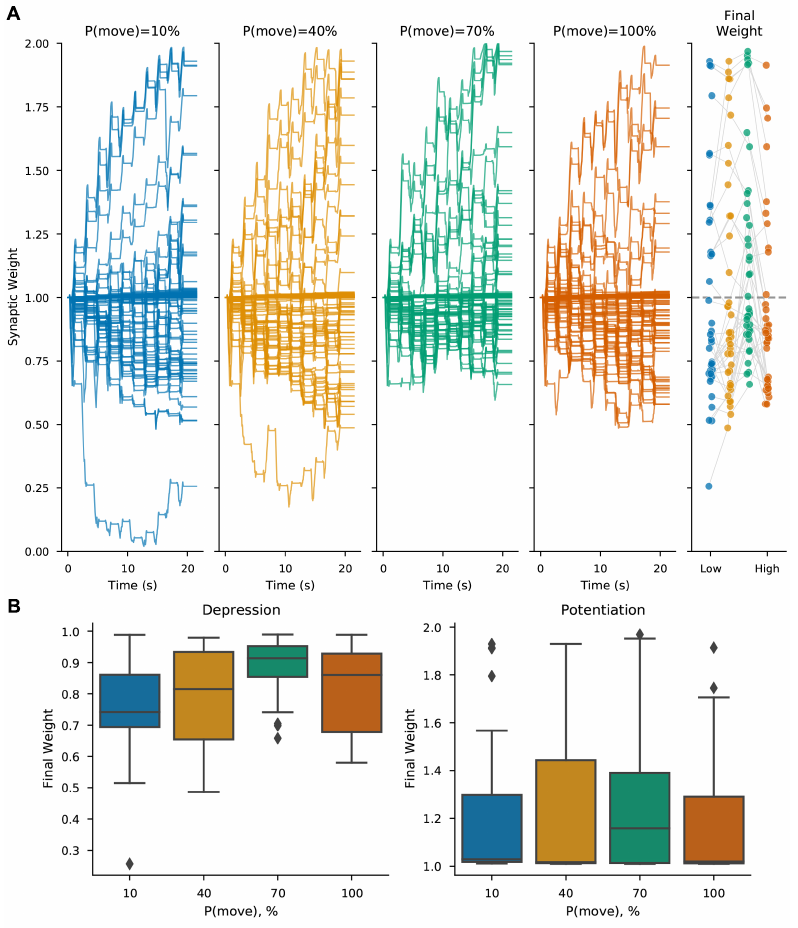
Figure A2. Synaptic weight for trials in which individual spikes were moved from one pre-synaptic input train to another train, with probability between 10 and 100%. ( A ) Synaptic weight is ro- bust to trial-to-trial variability created by moving spikes between trains. ( B ) Distribution of final weights grouped by potentiation and depression for variability introduced by moving spikes be- tween trains. Correlation of ending synaptic weight versus variability was significant for depressing synapses (R = 0.221, p = 0.008, N = 142 events), but not for potentiating synapses (R = 0.014, p = 0.873, N = 129